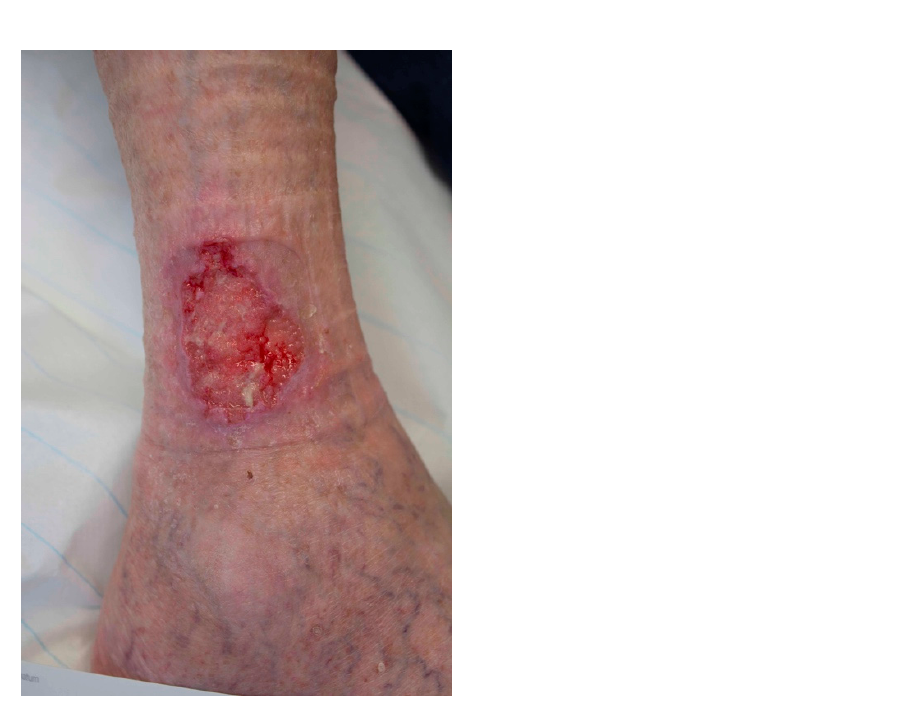
Figure 4. Example of an SCC on the toe, presenting as a chronic ulcer of an unknown etiology.